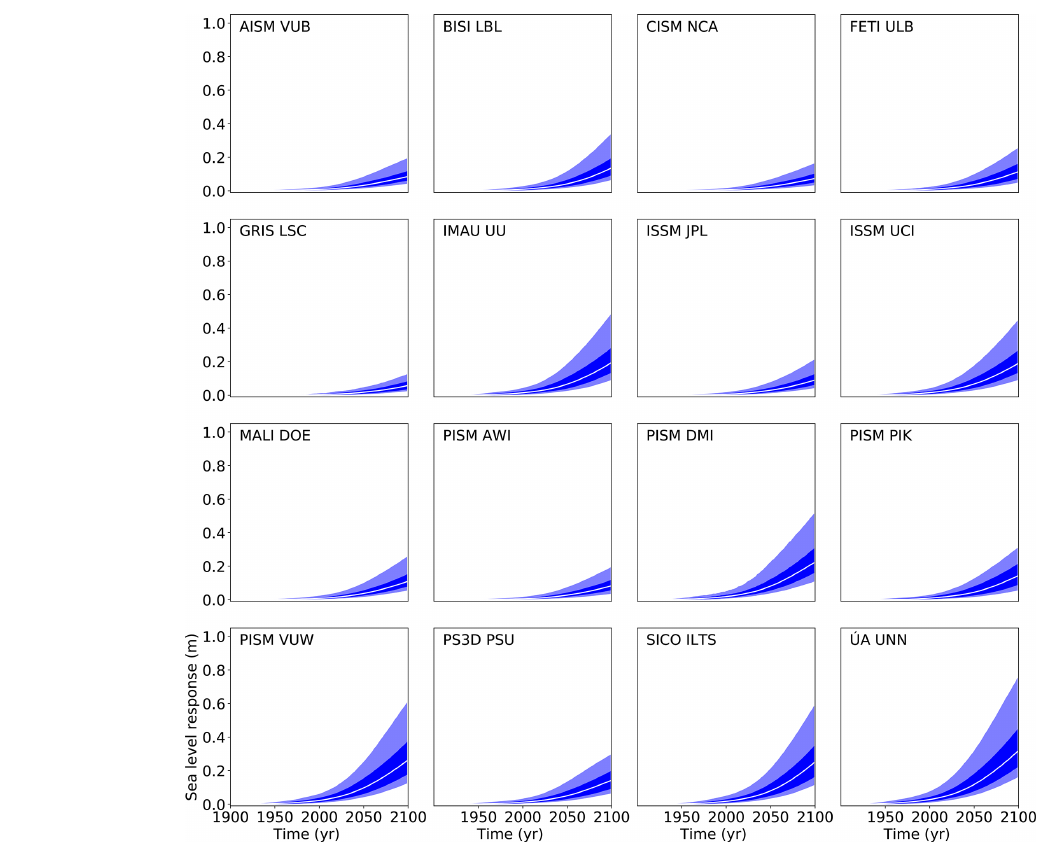
Figure 8. Projection of Antarctica’s sea level contribution under the RCP2.6 carbon concentration scenario following the procedure depicted in Fig. 1 and detailed in Sect. 2. The white line represents the median value, the dark shading the likely range (66th percentile around the median), and the light shading the very likely range (90th percentile around the median). Compare Tables 7–10 for the values and their comparison to the other